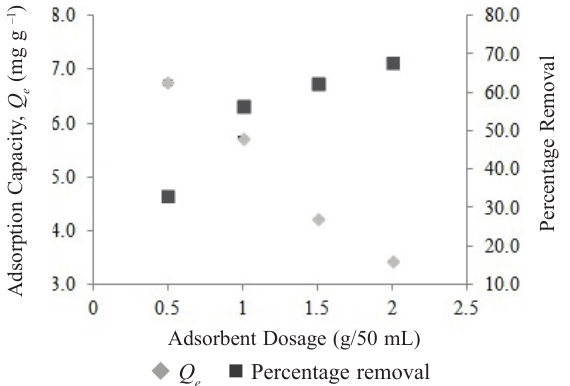
Fig. 8 – Effect of adsorbent dose on percentage removal and adsorption capacity for Reactive Green 19 adsorption (initial dye concentration = 200 mg L –1 ; pH = 6; contact time = 220